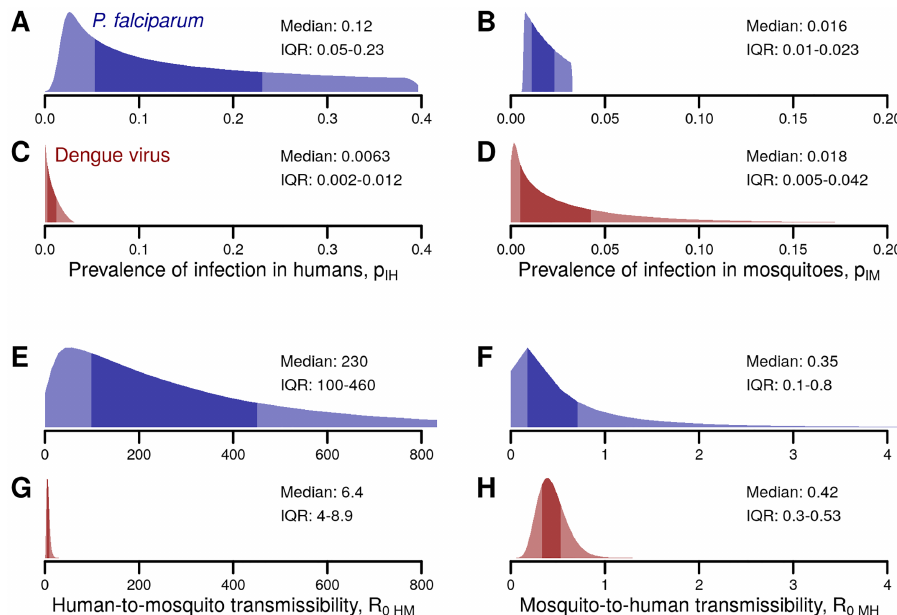
Fig 2. Distributions of parameters in the branching process for P . falciparum and dengue virus introduction. The prevalenceof infectionin humans and mosquitoesis characterized by Bernoulli distributions with parametersp IH (A and C) and p IM (B and D), respectively. Transmissibility for humans to mosquitoesand mosquitoesto humans are characterized by Poisson distributions with parameters R 0HM (E and G) and R 0MH (F and H), respectively.The dark shadedareas in each distribution indicate the interquartile range. Each panel provides the median and the interquartile range (IQR) of the correspondingdistribution.